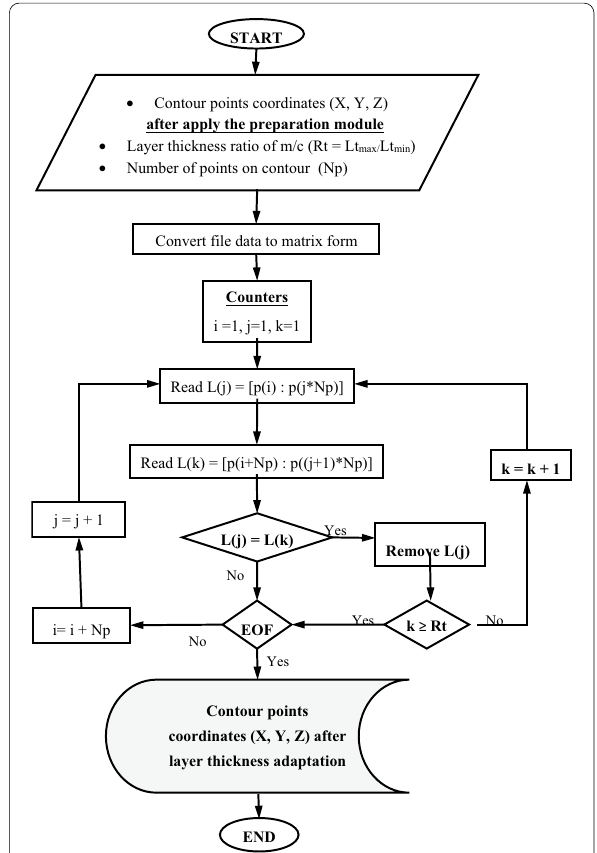
Fig. 6 Flowchart of the proposed adaptive slicing approach